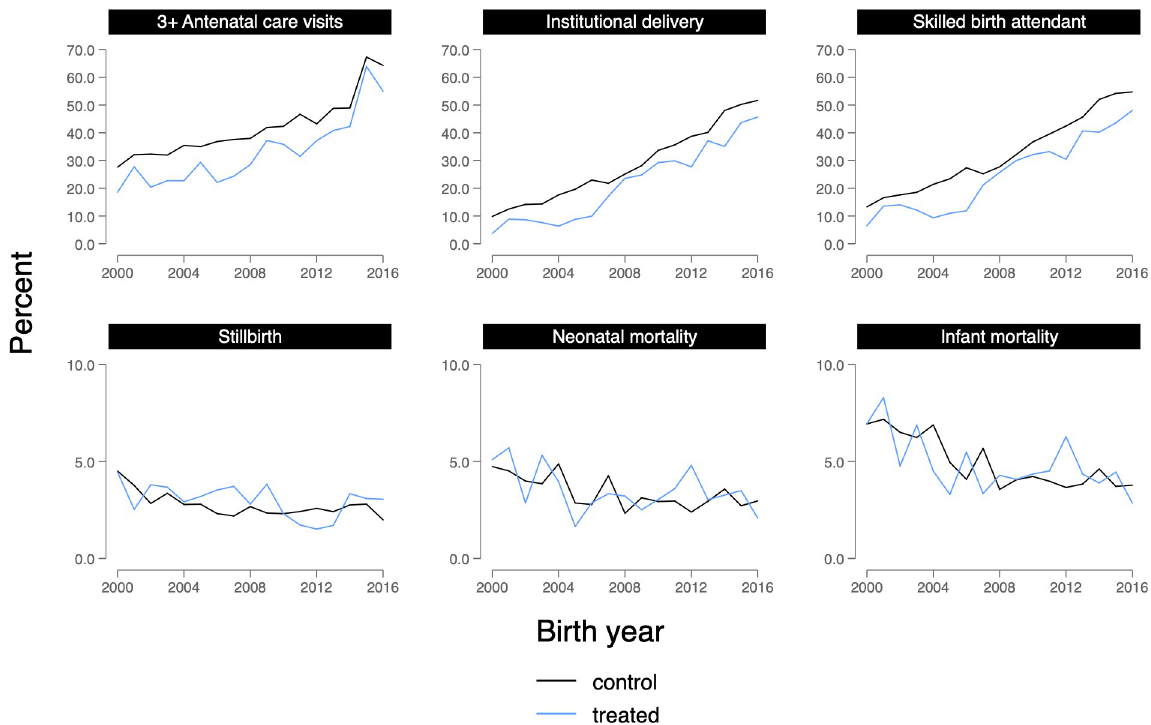
Fig 2. Trends in measures of maternal health services utilization, stillbirth, and neonatal and infant mortality among Bangladesh MHVS respondents, 2000–2016. MHVS, Maternal Health Voucher Scheme.